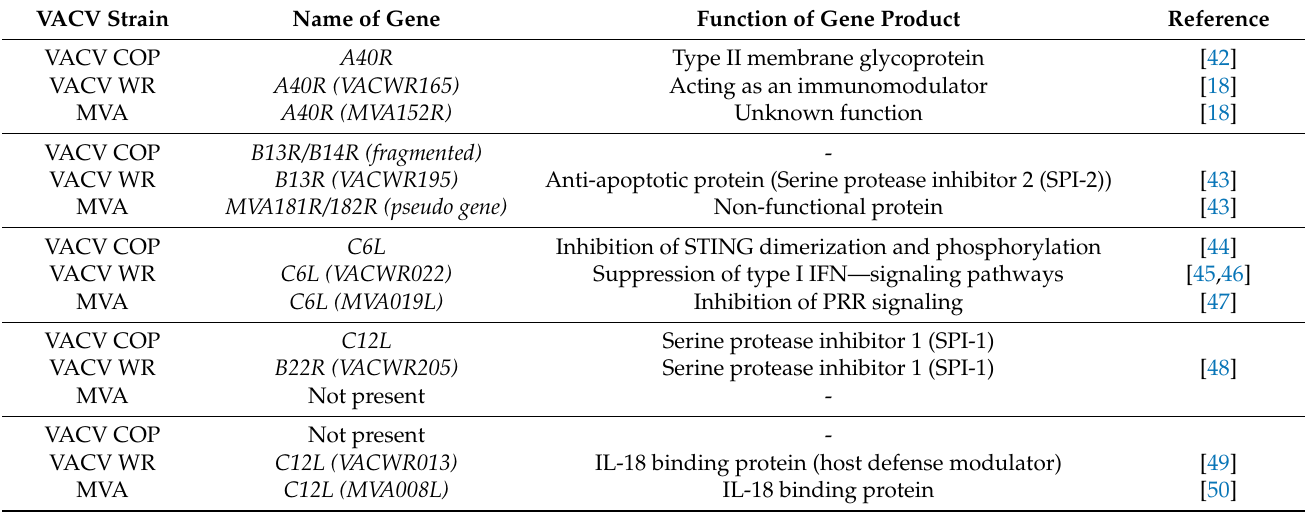
Table 1. Homologous genes in VACV strains COP (Copenhagen), WR (Western Reserve), and MVA (Modified vaccinia virus Ankara) and their functions. Genes are named according to the nomenclature used for VACV COP [39]. Genes present in VACV WR [40] and MVA [41] are additionally indicated in the respective nomenclature which is currently used for these strains. (-) indicates absent or lost gene